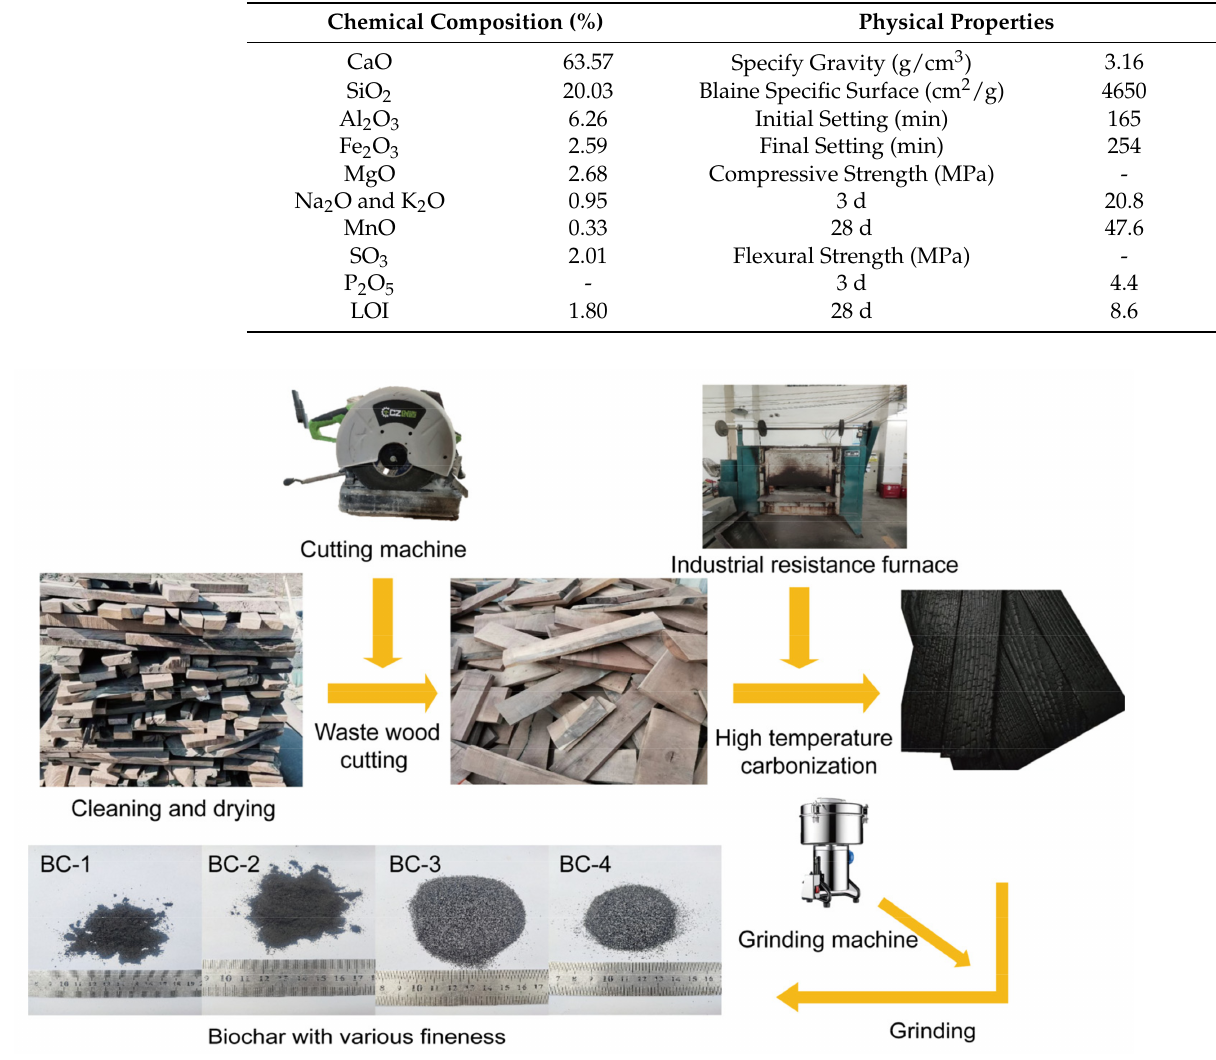
Table 1. Chemical composition and physical properties of cement.